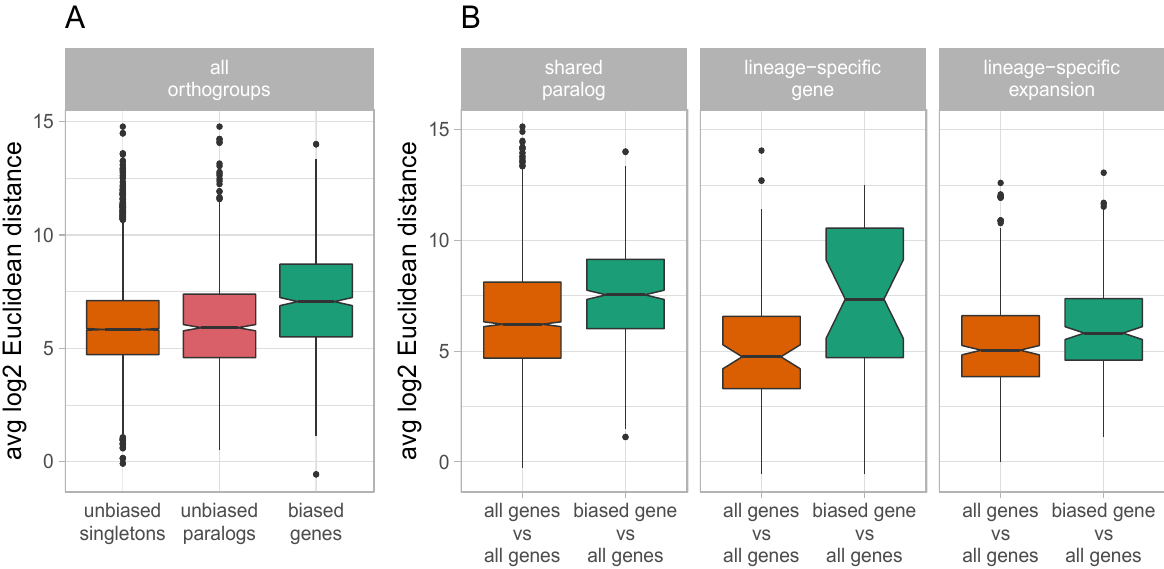
Figure 3. Expression divergence of duplicate genes. Boxplot of the average gene expression divergence between genes among orthogroups, as calculated using log2 Euclidean distances for ( A ) unbiased genes and biased genes, and for ( B ) paralogs across different gene categories.